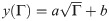
Refined data analysis for local marriages in Italy.Panel a: log-log scale plot of LMαi,y versus Γαi,y, where different regions are denoted in different colours and symbols, as explained in the legend. As discussed in the text, these data are particularly noisy, yet one can bin the whole set of data (green squares) and get the best-fit (solid line). This is given by the function y(Γ)=aΓ+b, in agreement with the theoretical result (2). The best-fit coefficients are a = 1.96 and b = −1.59 ⋅ 10−4. Notice that the parameter b accounts for the standard deviation associated to binned data. It is clear, even by visual inspection, that most regions systematically deviate from the best-fit curve. In the insets we show, as examples, the data pertaining to two selected regions, namely Emilia-Romagna (upper inset) and Campania (lower inset). Notice that the related data lay, respectively, below and above the best-fit curve previously obtained for the whole data set (solid line). Panel b: For each region we calculate ρ
α, as defined in the text and deepened in the Theoretical Protocol Section. The horizontal line is drawn as a reference for the unitary value. Notice that, for most regions, the deviation with respect the unitary value is significant. From this plot we can distinguish regions displaying a relatively large number of marriages (i.e., ρ
α > 1) and regions displaying a relatively small number of marriages (i.e., ρ
α < 1). This division is highlighted in the colormap presented in panel c. Remarkably, regions exhibiting analogous deviations share a sharp geographical proximity: regions with ρ
α > 1 (bright shading) correspond to Southern Italy, while regions with ρ
α < 1 (dark shading) correspond to Northern Italy. Panel d: the two clusters of regions highlighted are analysed separately. For each we bin the related raw data and get a best fit, still according to the function y(Γ)=aΓ+b, obtaining a
up = 2.29 and b
up = −4.39 ⋅ 10−4 (R
2 = 0.98) for the set of regions with ρ
α > 1, and a
down = 1.66 and b
down = −1.52 ⋅ 10−4 (R
2 = 0.99) for the set of regions with ρ
α < 1; notice that a
up/a
down ≈ 1.4. Binned data for the former set (triangles) and for the latter set (square) are shown in the main panel, together with the related best fits, in a log-log scale plot. These fits are significantly better that the one obtained at the country level, suggesting the existence of internal heterogeneities. In the insets we compare these best fits with raw data for two regions (Calabria and Campania) with ρ
α > 1 (upper inset) and two regions (Emilia-Romagna and Lombardy) with ρ
α < 1 (lower inset). Notice that the two sets of data overlap only the pertaining fitting curve, further suggesting that the division highlighted here is not negligible.